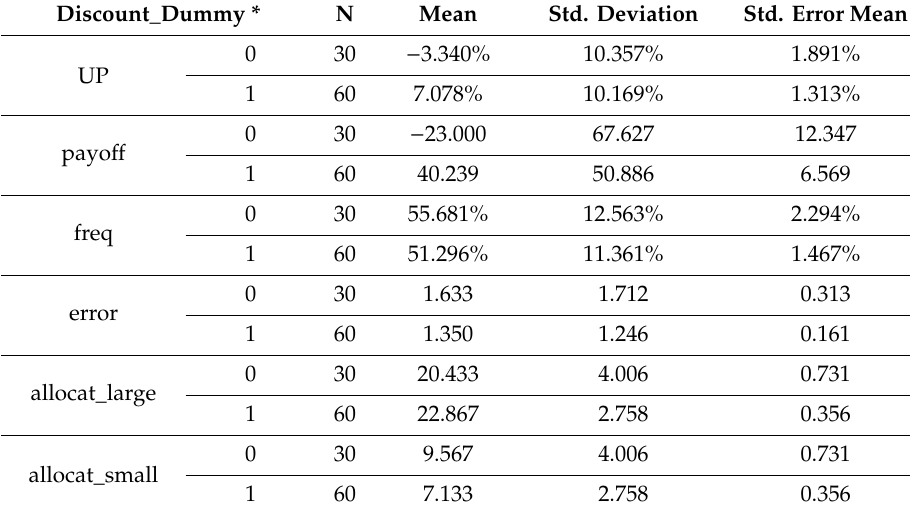
Table 4. Outcomes of auctions with or without a